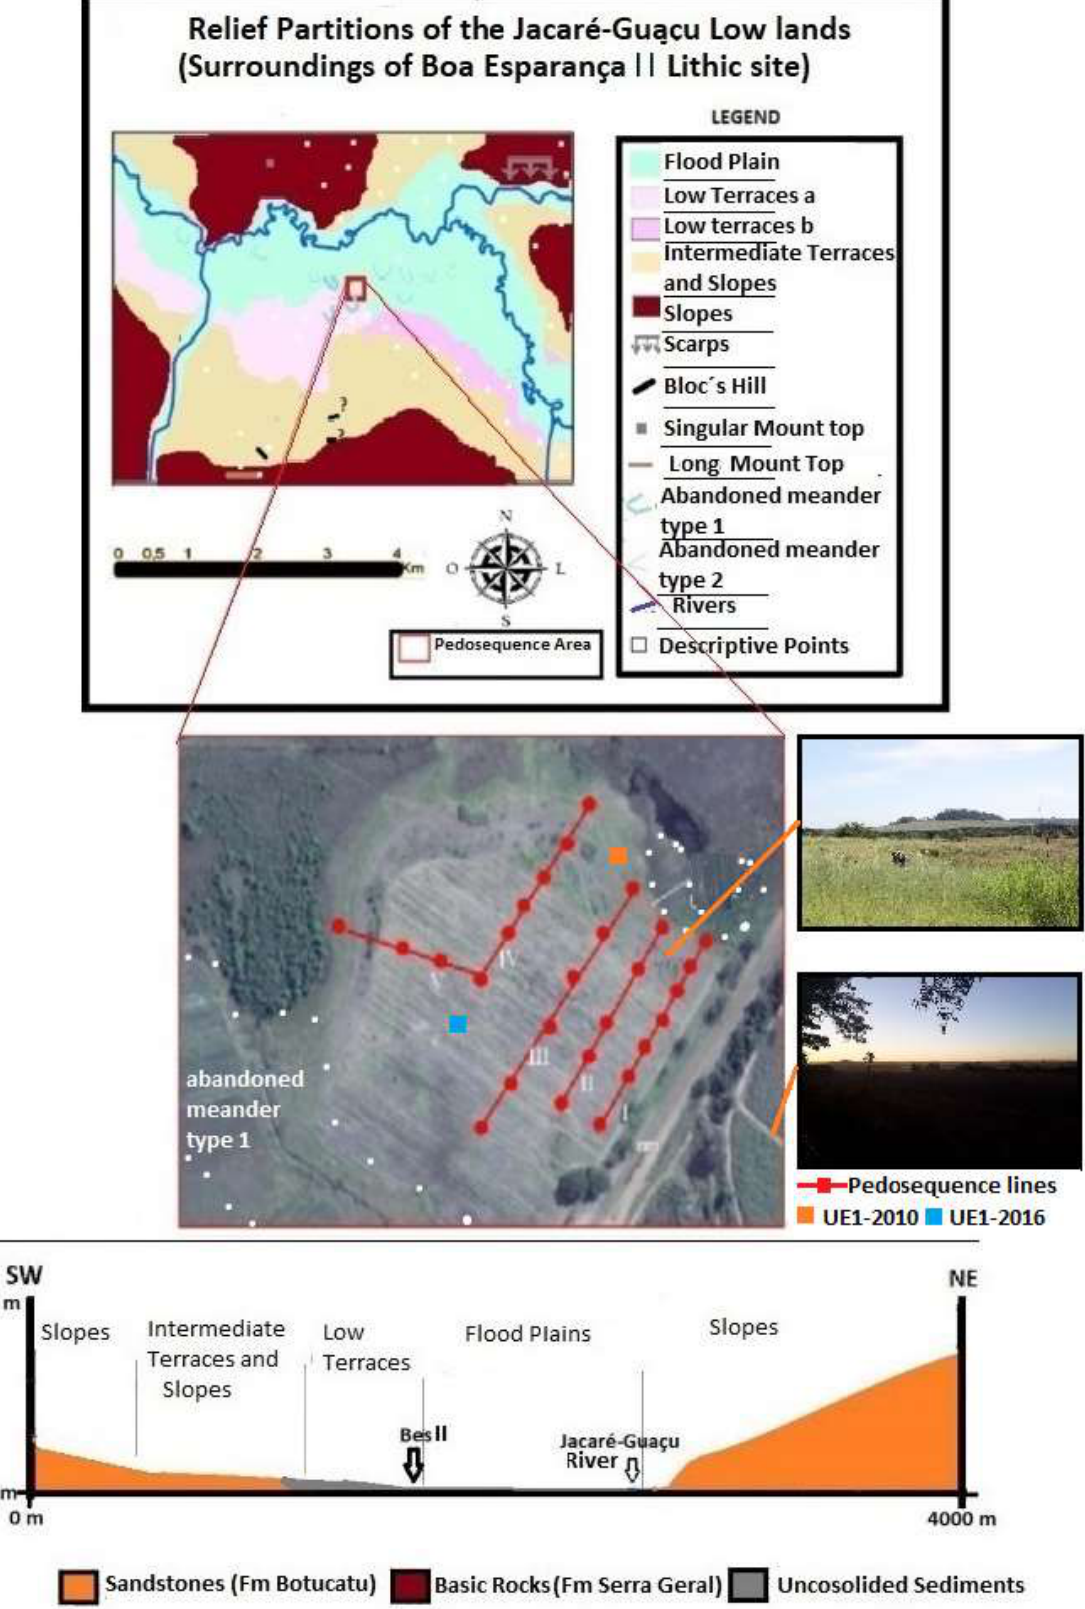
Figure 6. Composition with detailed subdivisions of the surroundings of BES II, and general landscape features of the area. Source: Cheliz